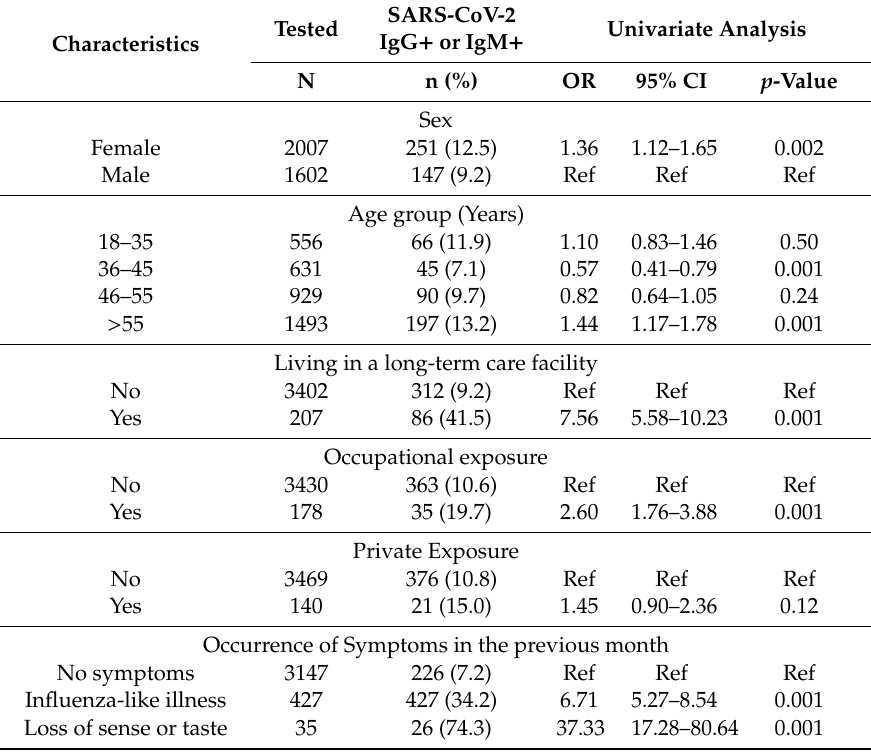
Table 3. Prevalence of Sars-CoV-2 IgM and IgG antibodies and univariate analysis of factors potentially associated with infection ( n = 3609).